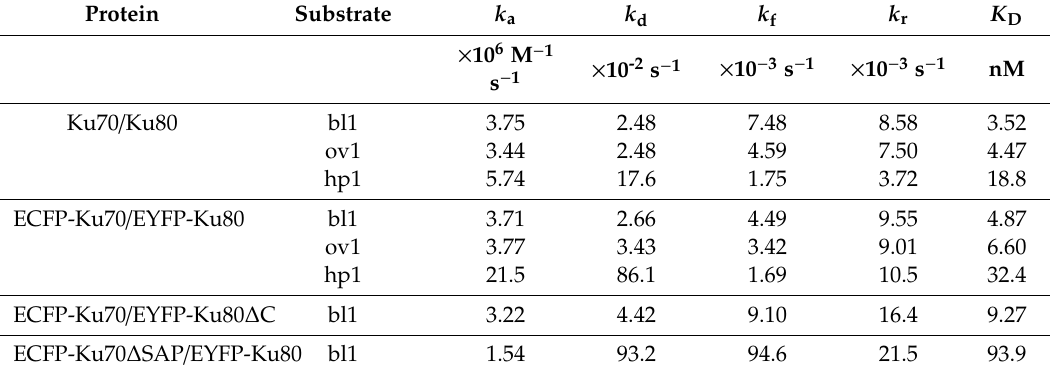
Binding of Ku70 / 80, ECFP-Ku70 / EYFP-Ku80, and labeled Ku variants—Ku80 ∆ C, Ku70 ∆ SAP—to di ff erent DNA substrates (blunt bl1, overhang ov1, and hairpin hp1; see Figure 1A) at 250 mM NaCl quantified using surface plasmon resonance. Kinetic constants were derived by fitting a model to the data that accounts for binding of Ku to the free DNA end and a small fraction interacting with the chip matrix. k a = association rate constant for binding of Ku to DNA; k d = dissociation rate constant for release of Ku from DNA; k f = forward rate constant for interaction with chip matrix; k r = reverse rate constant for interaction with chip matrix; K D = a ffi nity constant.